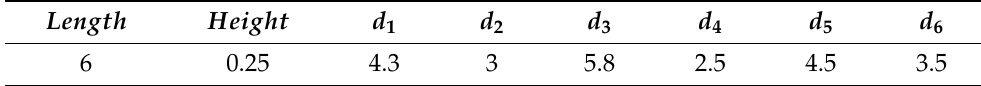
Table 5. FSS structure parameters (unit: